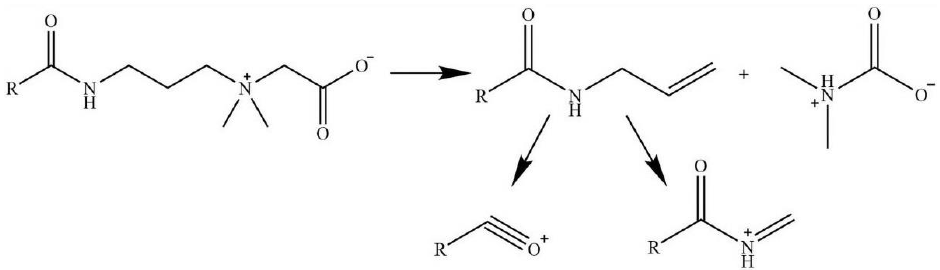
Figure 1. Destruction of CAPB under the influence of physical and chemical factors.